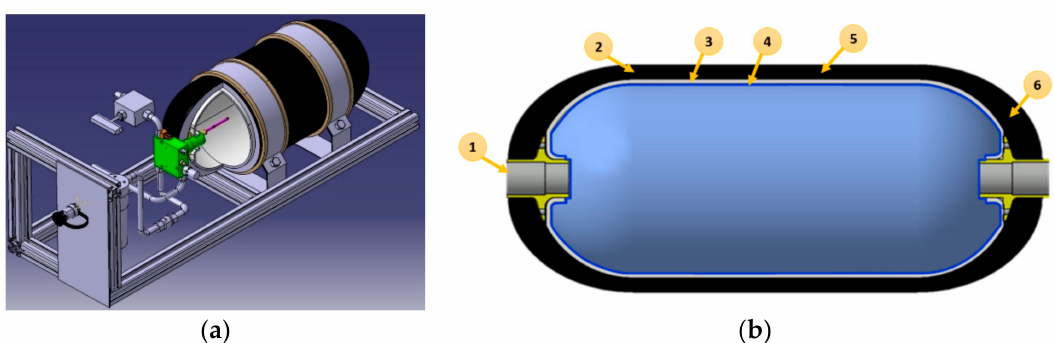
Figure 1. Scheme of a high-pressure hydrogen storage vessel. ( a ) A cross section and ( b ) a construction scheme: 1—inlet boss, 2—composite load carrying shell, 3—liner, 4—permeation reducing sol–gel coating, 5—cylindrical part, 6—dome with visible PE liner